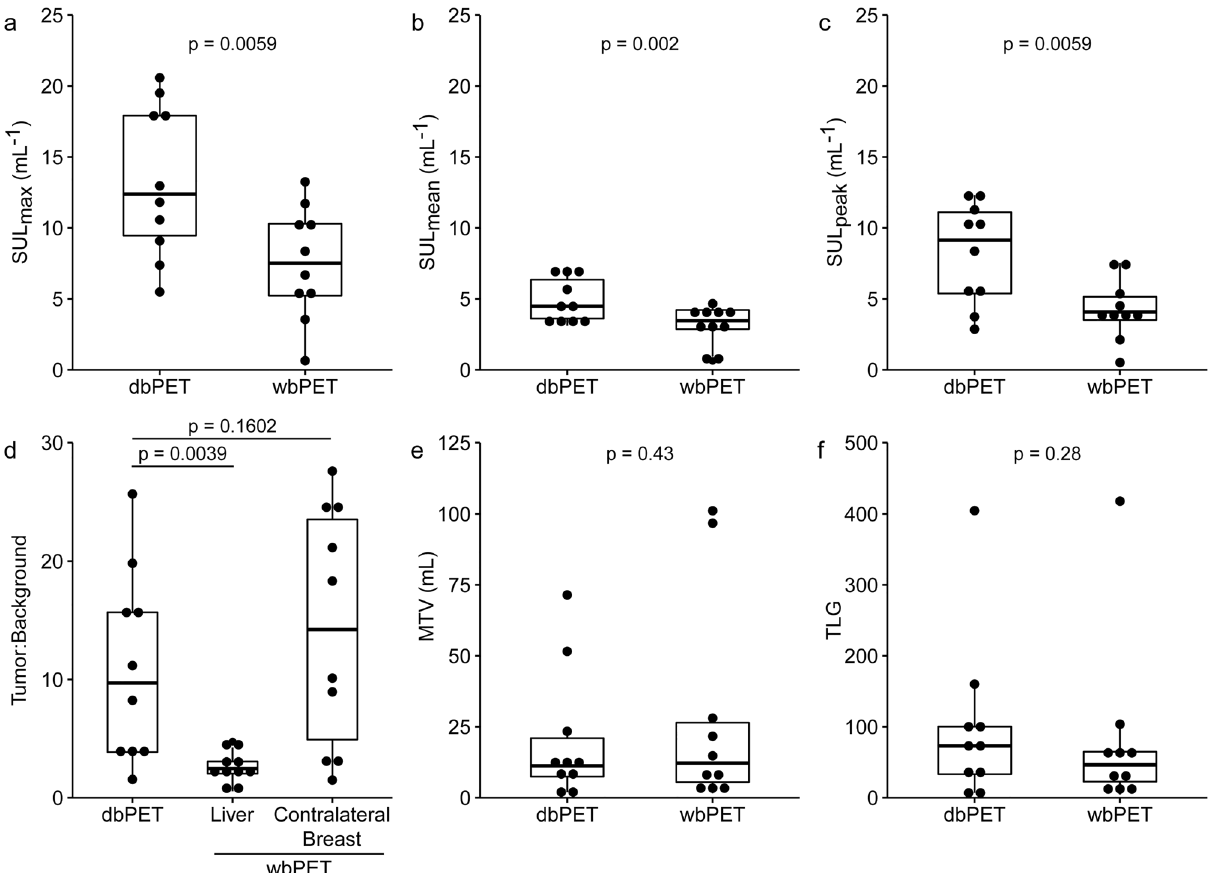
Figure 2. Comparison of [ 18 F]FDG uptake in lesions with dbPET and wbPET. ( a ) SUL max ; ( b ) SUL mean ; ( c ) SUL peak ; ( d ) Ratio of SUL peak in tumor to SUL mean in the background. For wbPET, the background VOIs were defined separately on the liver and the contralateral breast. Background VOI was defined in the contralateral breast for dbPET. ( e ) Metabolic tumor volume (MTV); and ( f ) Total lesion glycolysis (TLG).